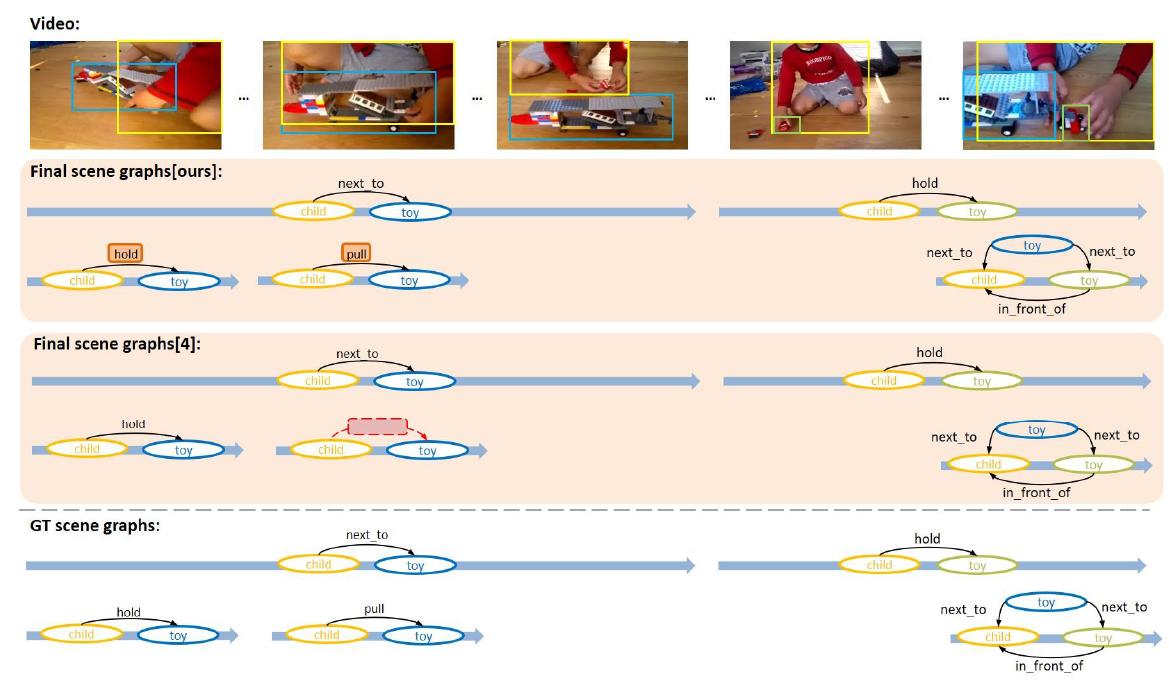
Figure 6. First example of VidSGG task performed by the proposed model.